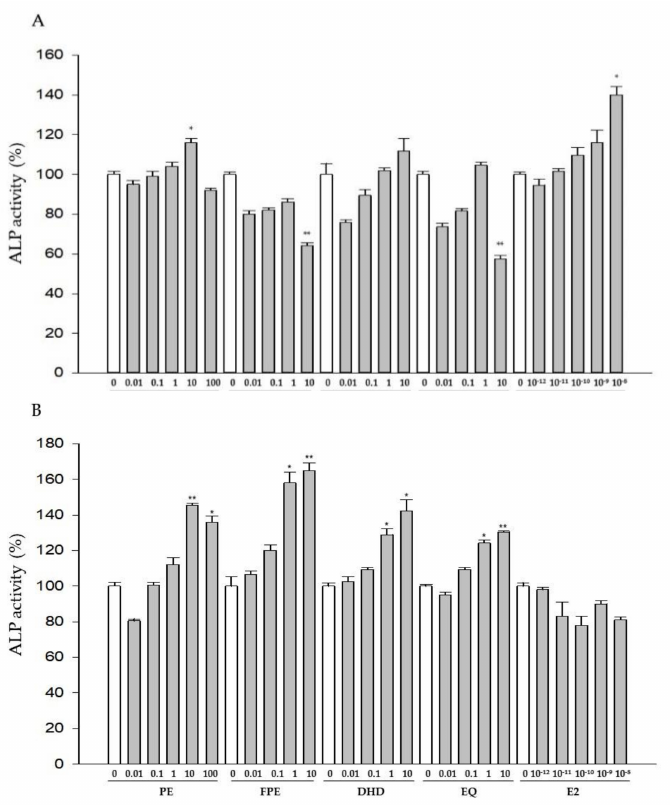
Figure 3. Effects of alkaline phosphate (ALP) activity in MG63 cells: ( A ) 96 h after treatment; ( B ) 120 h after treatment. PE: Pueraria lobata extract; FPE: fermented Pueraria lobata extract; DHD; dihydrodaidzein; EQ; equol. The results are expressed as a mean ± SEM ( n = 3). * p < 0.05 compared to control, ** p < 0.01 compared to